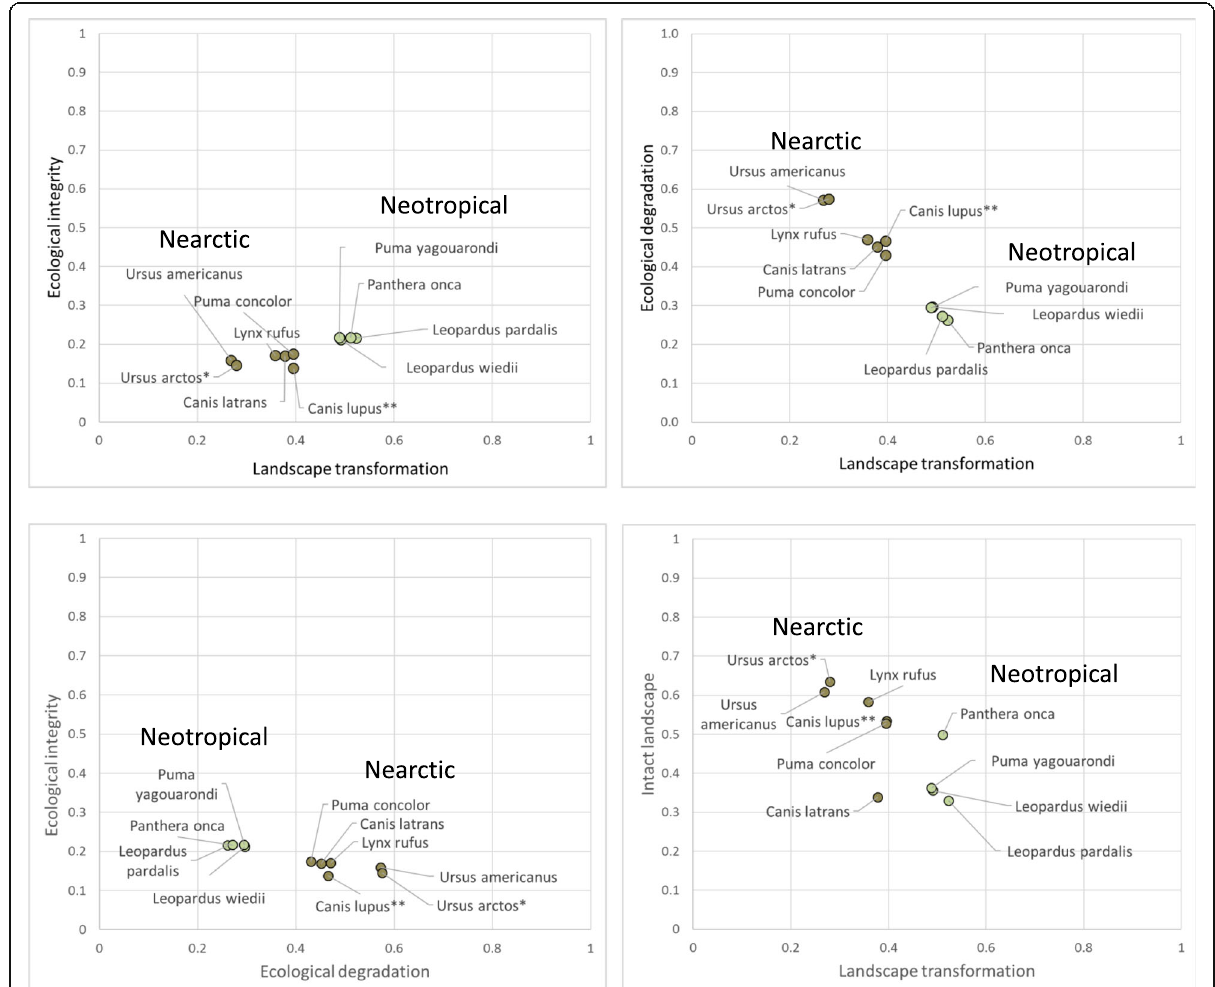
Fig. 7 Relationship between ecological integrity, ecological degradation, intact landscapes, and landscape transformation for different patterns of biogeographic distribution of apex predators in